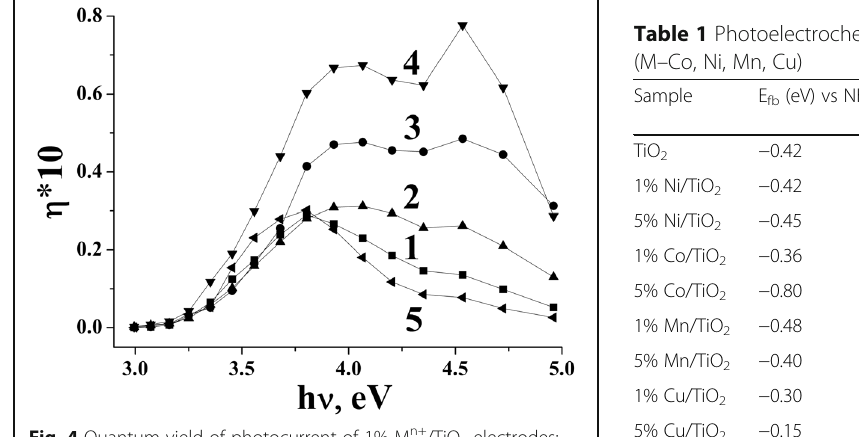
Fig. 4 Quantum yield of photocurrent of 1% M n+ /TiO 2 electrodes: TiO 2 ( 1 ), Co/TiO 2 ( 2 ), Ni/TiO 2 ( 3 ), Mn/TiO 2 ( 4 ), and Cu/TiO 2 ( 5 )